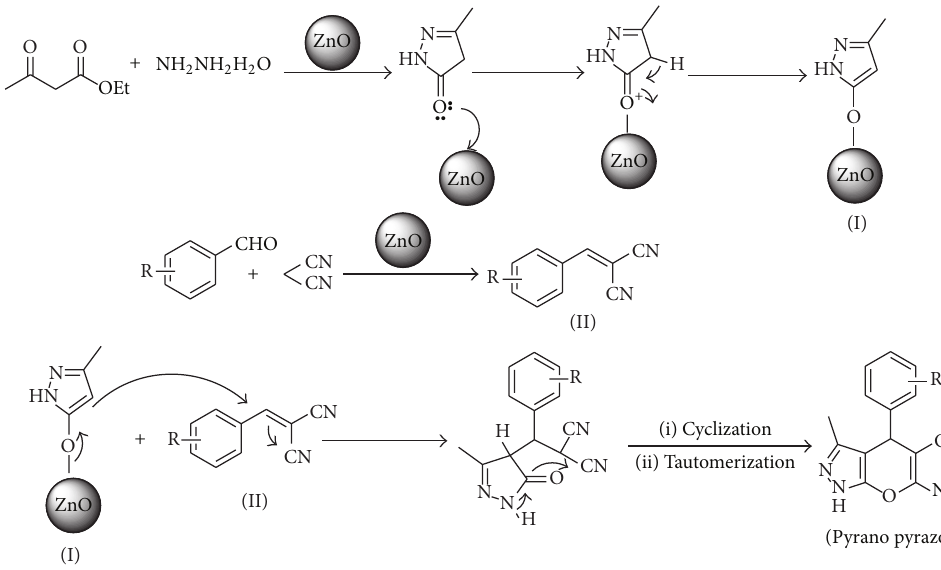
Figure 2: Plausible mechanism for the ZnO nanoparticle catalyzed four-component synthesis of